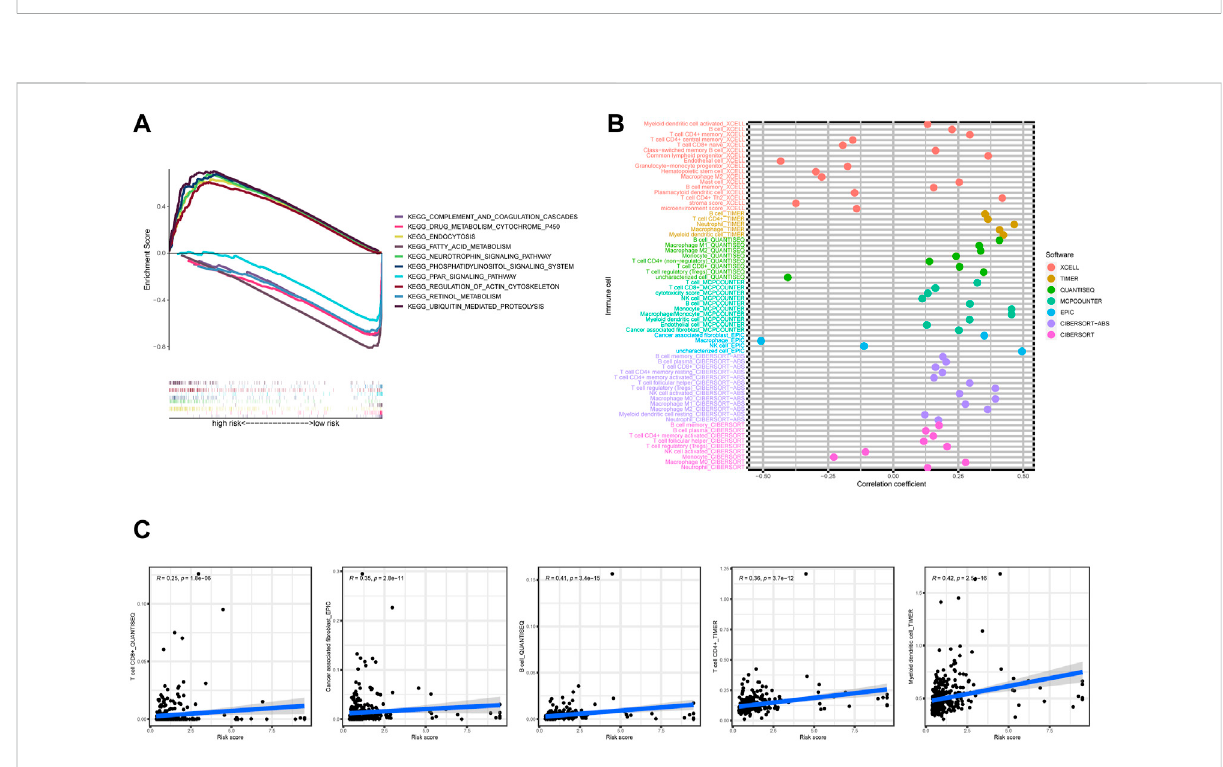
FIGURE 7 (A) Thetop fi vepathwayswithenrichmentinthehigh-andlow-riskgroupswiththeGSEAanalysis, (B) thebubblechartshowingriskgroupsand immune cells, and (C) line graph demonstrating risk score and immune